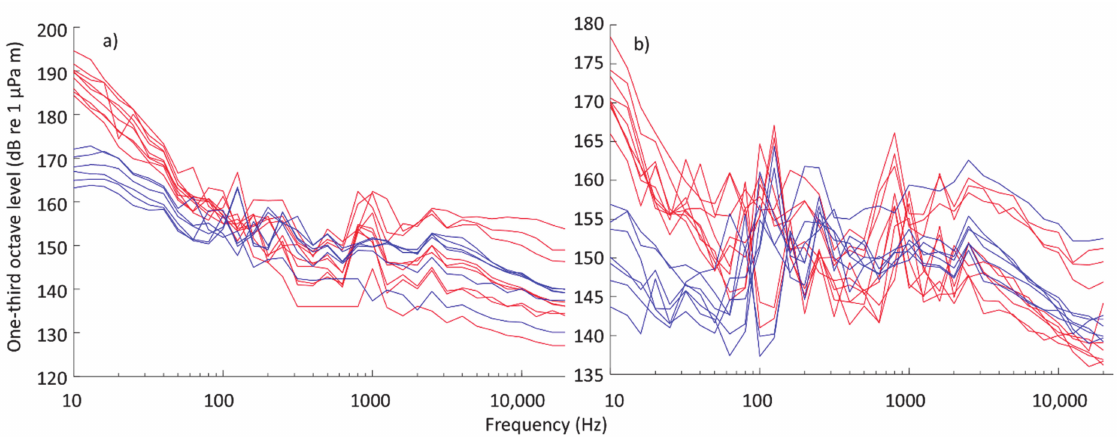
Figure 6. One-third octave band monopole source levels (red) and radiated noise levels (blue) for two example vessels ( a , b ) travelling at the same speed (data taken from Wladichuk et al.